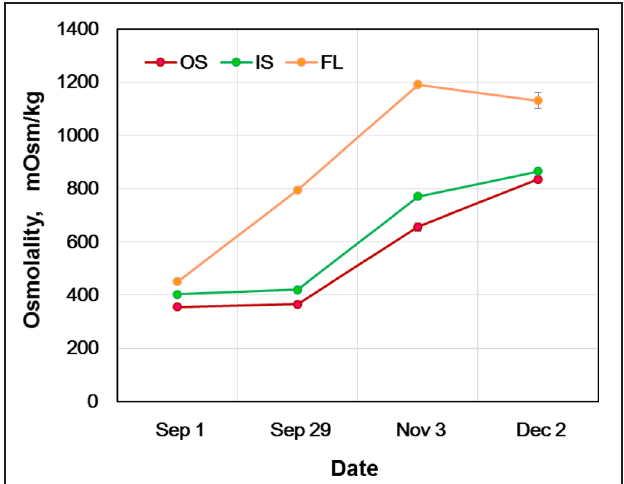
FIGURE 6 | Seasonal changes in the osmolality of flower bud tissues of R. japonicum . OS, outer scale; IS, inner scale; FL, floret. The data are mean ± SE ( n = 4). The error bars that are smaller than the symbols are not